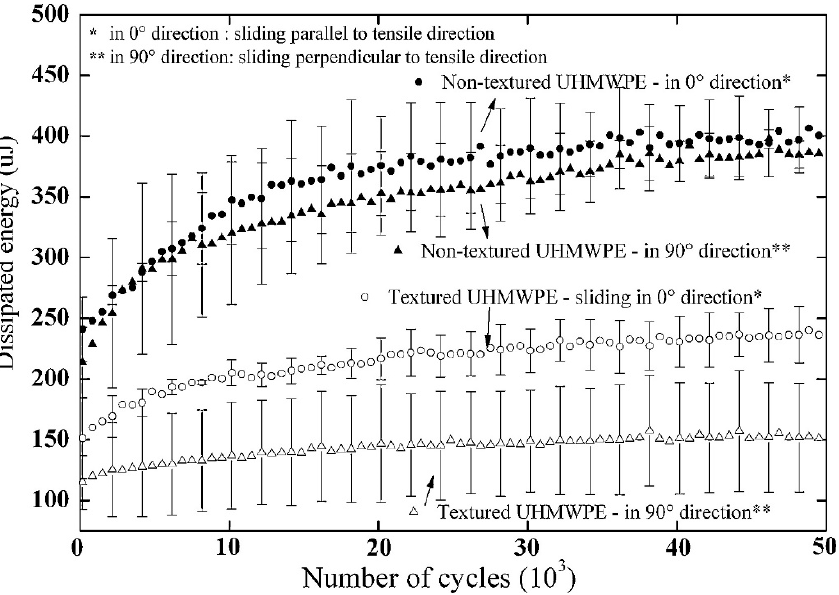
Figure 10. Plots of dissipated energy versus sliding cycles for textured and un-textured UHMWPE. Reprinted with permission from [17]. Table 5. E ff ect of texturing on tribological